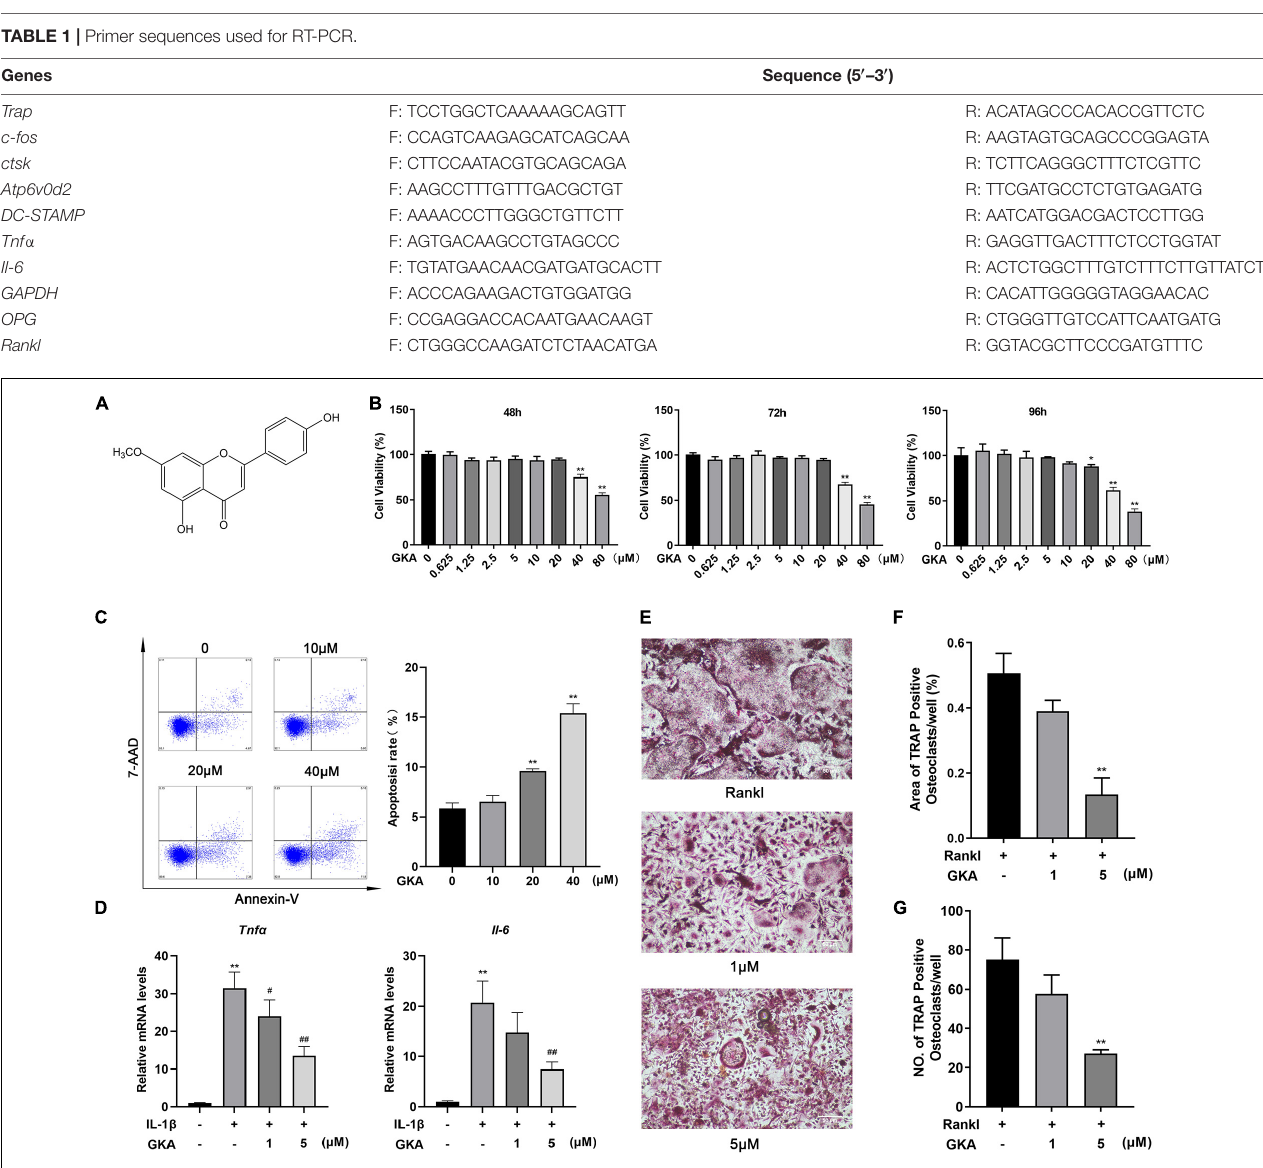
FIGURE 1 | Genkwanin (GKA) induced cell apoptosis and prevented osteoclastogenesis stimulated by RANKL in vitro . (A) Structural formula of GKA. (B) Cell viability was investigated by CCK-8 assay at different time points. (C) BMMs were treated with different concentration of GKA for 48 h, and the cell apoptosis rate was examined by flow cytometry. (D) BMMs were induced by IL-1 β (10 ng/ml) and treated with GKA for 6 h, and Tnf α and Il-6 were detected by RT-PCR. (E) BMMs were treated with various concentrations of GKA. Representative image of TRAP-positive osteoclasts (scale bar, 500 µ m). (F,G) The number and area of TRAP-positive multinucleated osteoclasts ( > 3 nuclei) were calculated. The data were described as mean ± SD (* P < 0.05, ** P < 0.01, relative to the control group. # P < 0.05, ## P < 0.01, GKA treatment group relative to the positive group, analyzed by one-way ANOVA), n = 3. Error bars refer to standard deviations from three replicates.